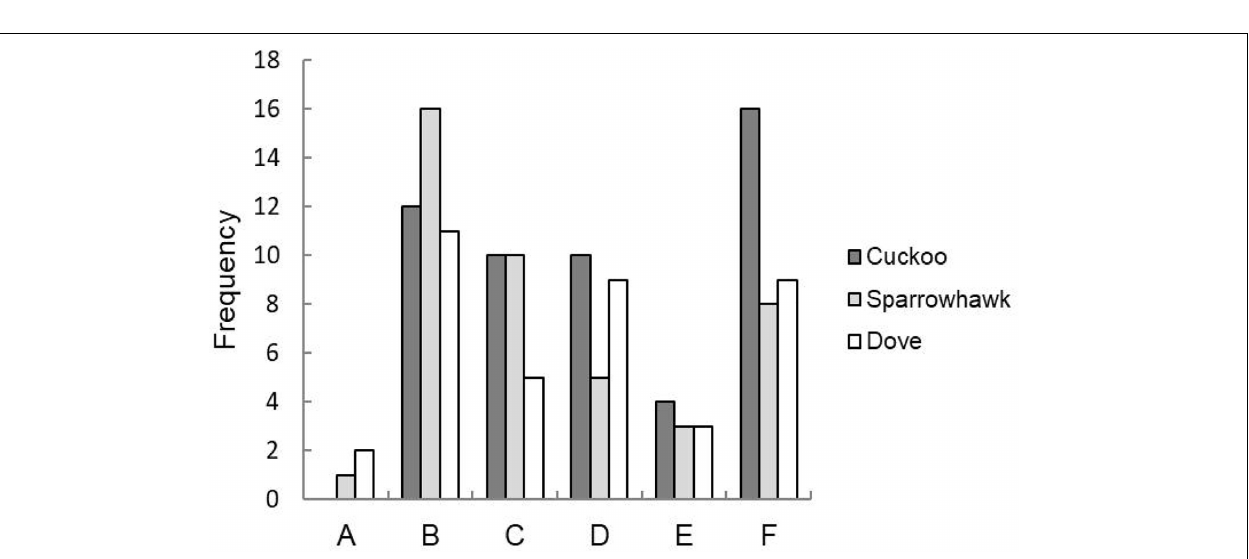
FIGURE 3 | Frequency of note types in alarm calls produced by A. orientalis toward cuckoo, sparrowhawk, and dove.